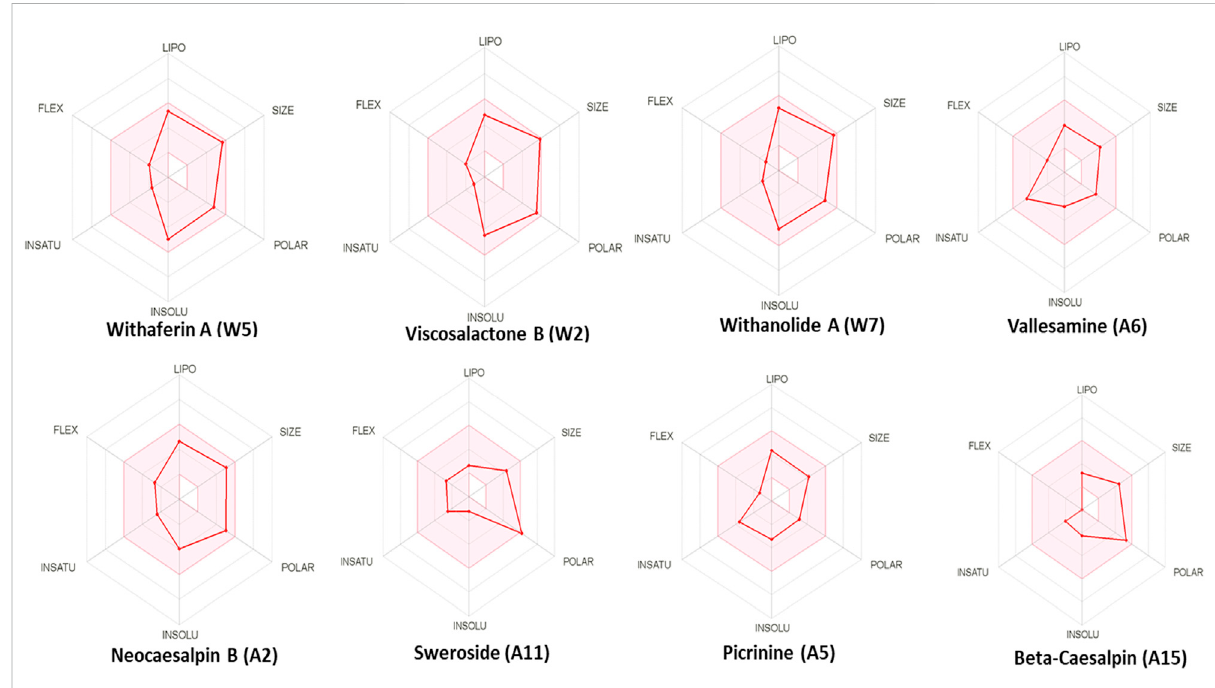
FIGURE 4 Radar plots of key phytoconstituents present in AYUSH-64 and Withania somnifera extracts.